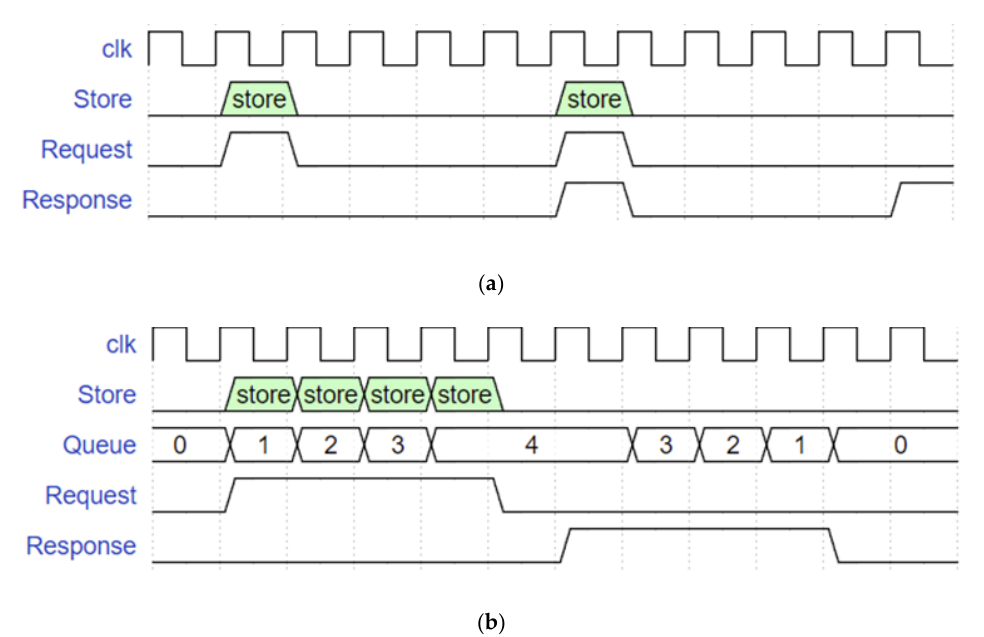
Figure 3. ( a ) Assuming that the store instruction takes five cycles to respond, they can only be exe- cuted one by one because of stalling. ( b ) Added store-queue, multiple store instructions can be exe- cuted consecutively without